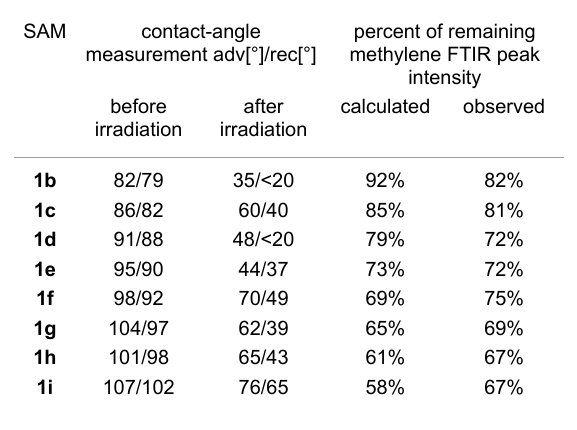
Table 3: Contact angles and methylene loss (based on ATR–FTIR integration ratio, calculated and observed) before and after irradiation of SAMs based on compounds 1b – i